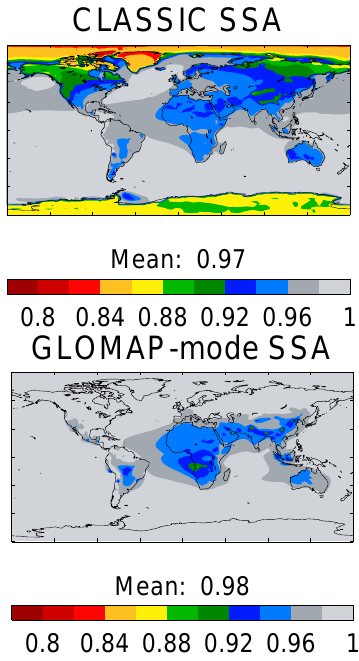
Fig. 4. Aerosol single-scattering albedo (SSA) at 0.55µm, inte- grated over the atmospheric column and averaged over the period 2000–2006 for CLASSIC (top) and GLOMAP-mode